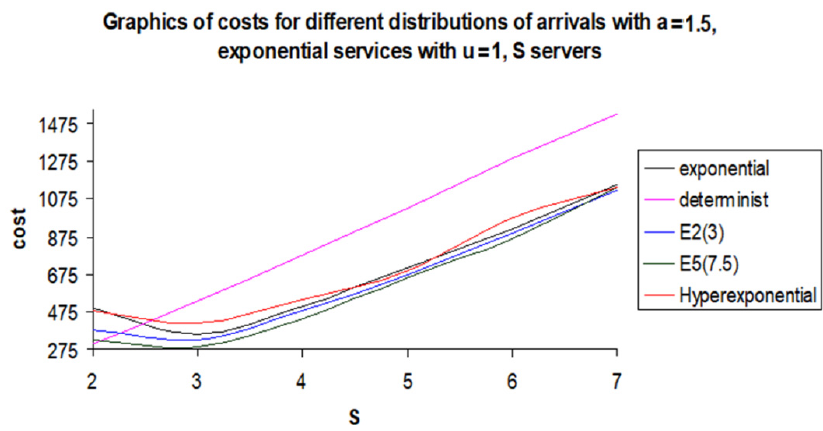
Figure 9. Graphics of costs for different distributions of arrivals, in terms of S.